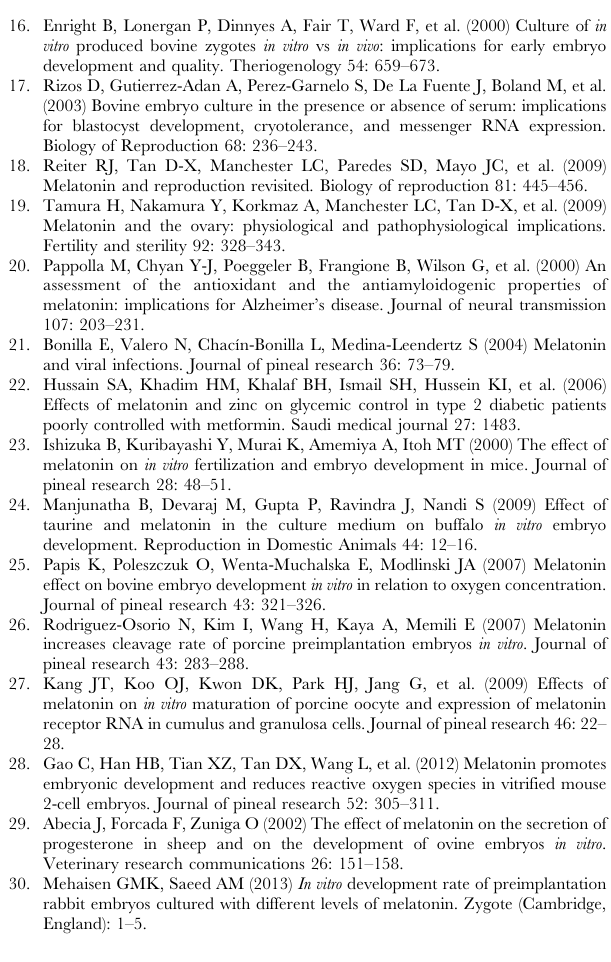
with PBS-PVA solutions little by little. (TIF) Figure S2 Effects of melatonin on the development of bovine embryos after vitrification and thawing. The red arrows represent dead blastocyst (defined as without re-expansion or development retarded blastocyst) and blue arrows represent hatched blastocyst (hatching is a phenomenon seen with embryos developing outside the body. Under natural conditions inside the body, the zona is believed to degenerate and disappear after the embryo reaches the uterine cavity and prepares to implant). Blastocysts were produced in IVC medium supplemented with or without 10 2 7 M melatonin, following vitrification and thawing at Day 7 of embryo culture, then cultured in IVC medium in a CO 2 incubator for 72 h. melatonin (10 2 7 M) significantly increased the hatched blastocyst rate from 24 h to 72 h and decreased the mortality rate from 48 h to 72 h after thawing.